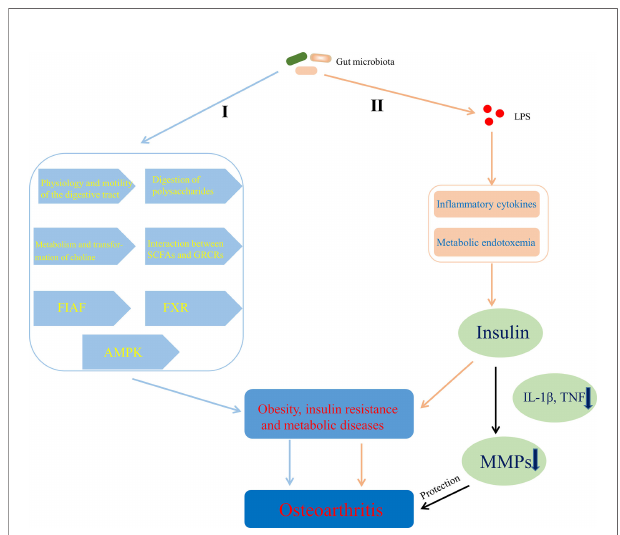
FIGURE 6 | Mechanisms of gut microbiota ’ s contributing to OA through affecting energy metabolism. I Gut microbiota contributed to obesity and metabolic diseases by helping to obtain energy and increase host fat storage via pathways involved in the physiology and motility of the digestive tract, the digestion of polysaccharides, the metabolism and transformation of choline, the interaction between SCFAs and GPCRs, FIAF, FXR, and AMPK. II LPS- mediated in fl ammatory pathway or metabolic endotoxemia contributed to obesity and insulin resistance by affecting the regulation of insulin secretion that can protect articular cartilage through inhibiting MMPs expression dependent on pro-in fl ammatory cytokines. SCFAs, short chain fatty acids; GPCRs, G protein-coupled receptors; FIAF, fasting-induced adipose factor; FXR, farnesoid X receptor; AMPK, adenosine monophosphate-activated protein kinase; LPS, lipopolysaccharide; TNF, tumor necrosis factor; MMPs, matrix